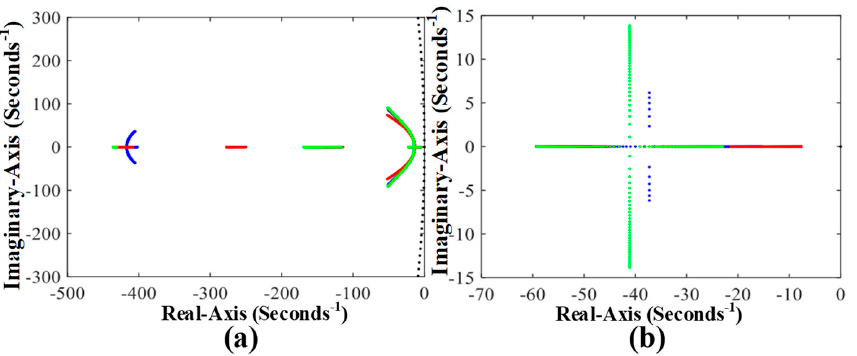
Figure 10. Pole distributions of system between different armature inductance in d -axis: ( a ) pole distribution diagram of motor before design; ( b ) pole distribution diagram of motor after design.